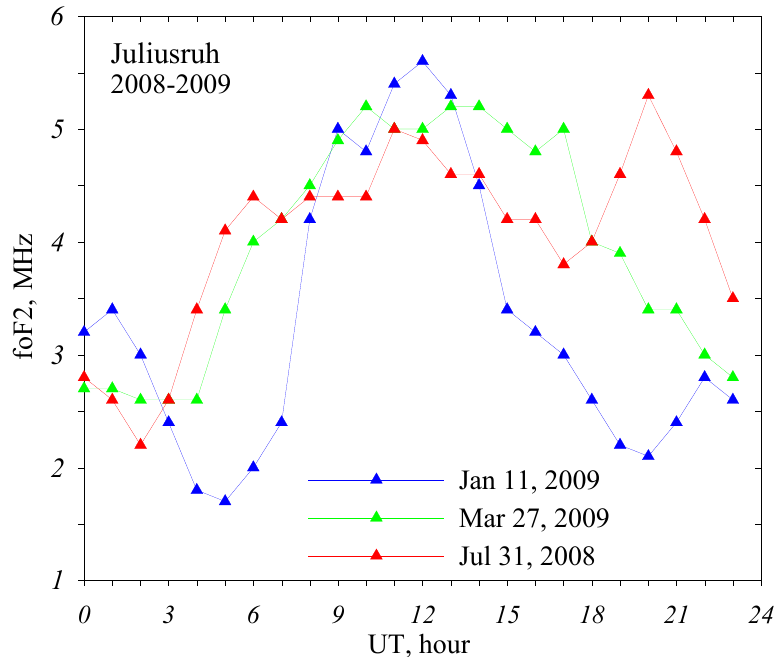
Figure 1. Well-pronounced foF 2 diurnal variations for three seasons at